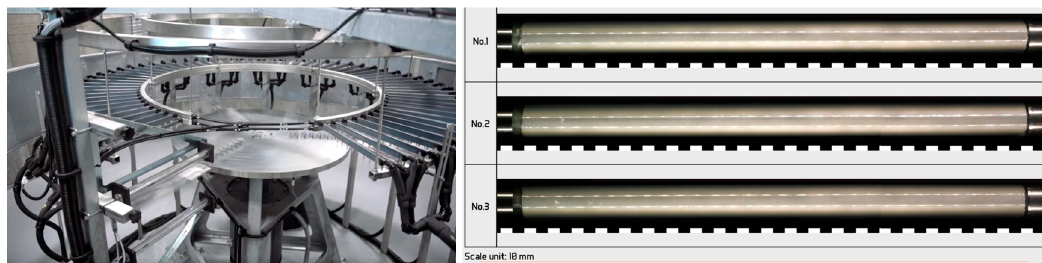
Figure 14. Rain erosion test facility and three specimens used at PolyTech Test & Validation A/S according to DNV-GL-RP-0171 [22] for the analysis and experimental validation.